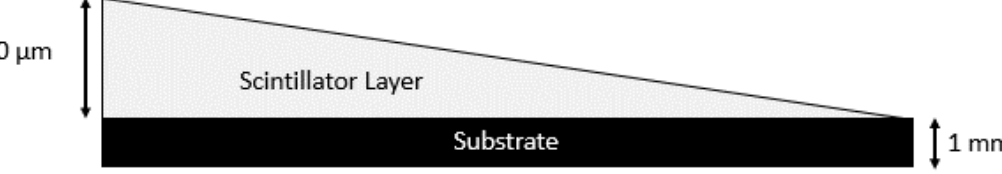
Figure 1. Schematic diagram of a wedged scintillator ( not to scale ). The wedge allowed a range of thicknesses to be simultaneously tested.